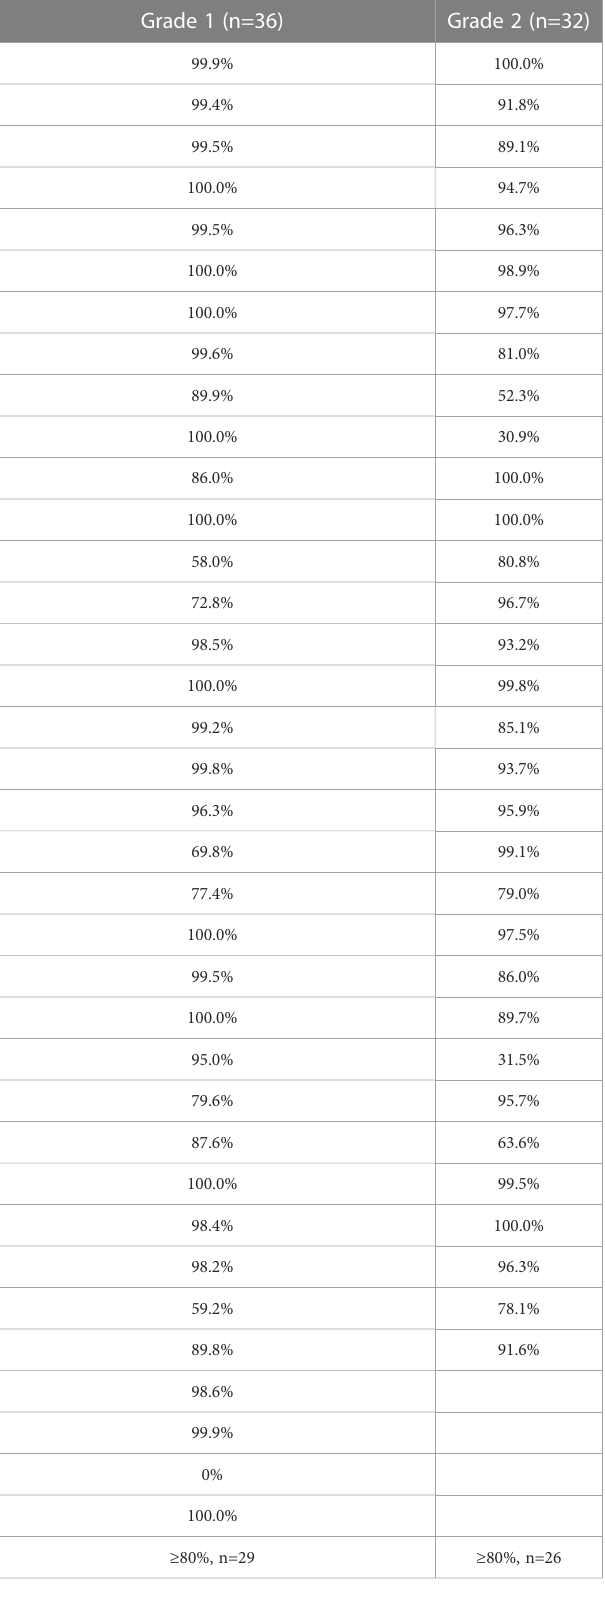
TABLE 7 Percentage of pneumonia patch covered by 26 Gy in grade 1 and 2 radiation pneumonitis patients. Grade 1 (n=36)